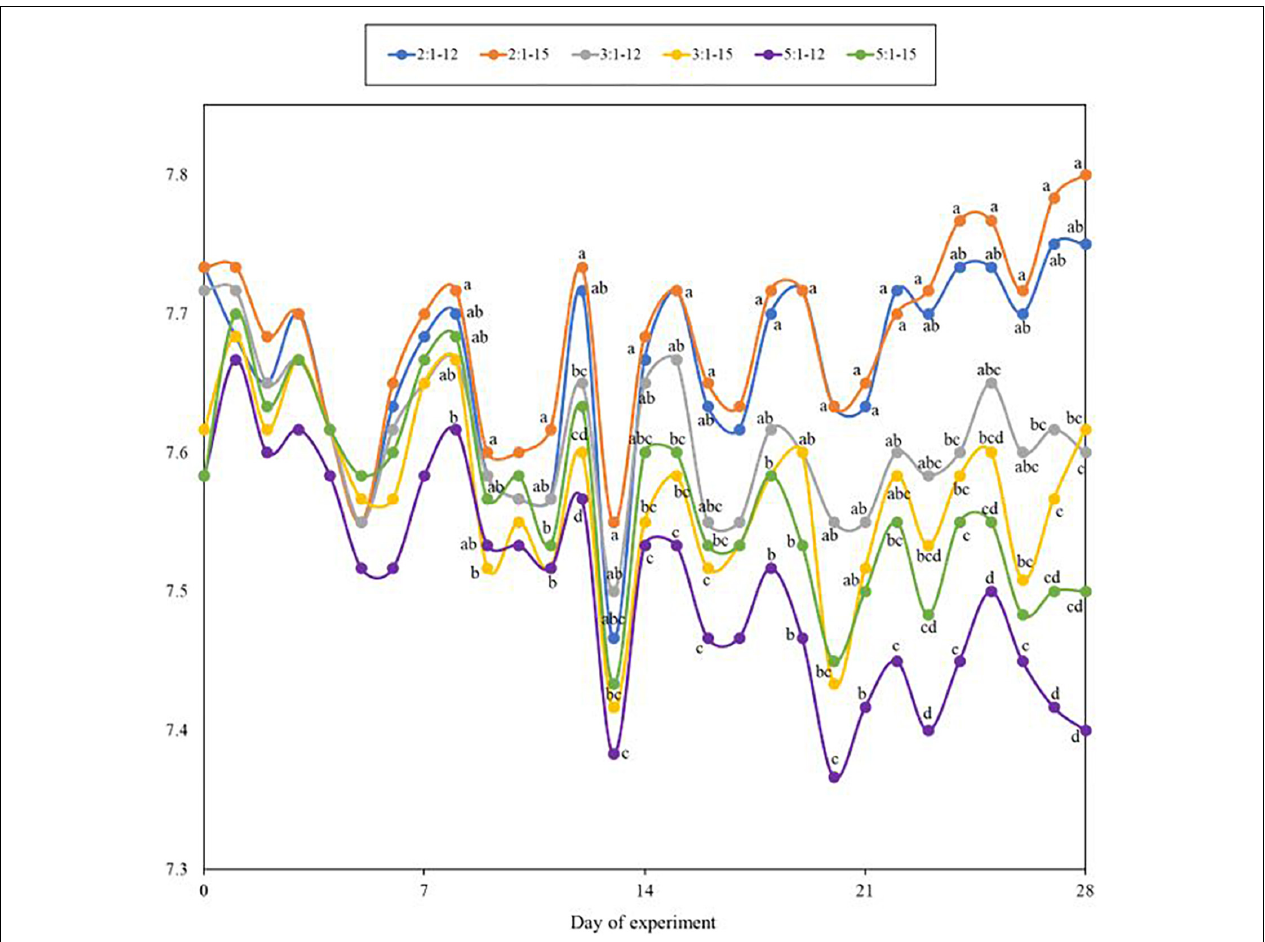
FIGURE 2 | Dynamic change of pH measured during the 4-week experiment. Each point represents the means of 3 replicates, and lower-case alphabet letters represent significant differences, followed by one-way ANOVA and Tukey’s HSD test ( α =